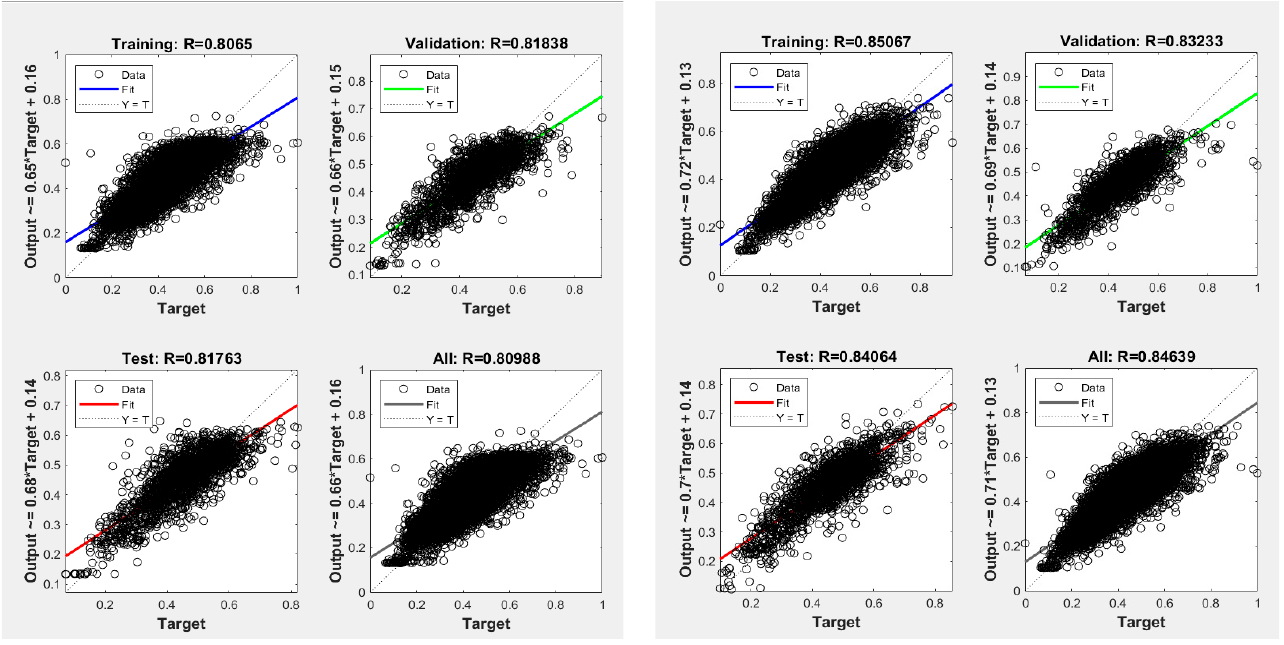
( b ) Residual plot of the night model with the LCZ Figure 13. Night model performance